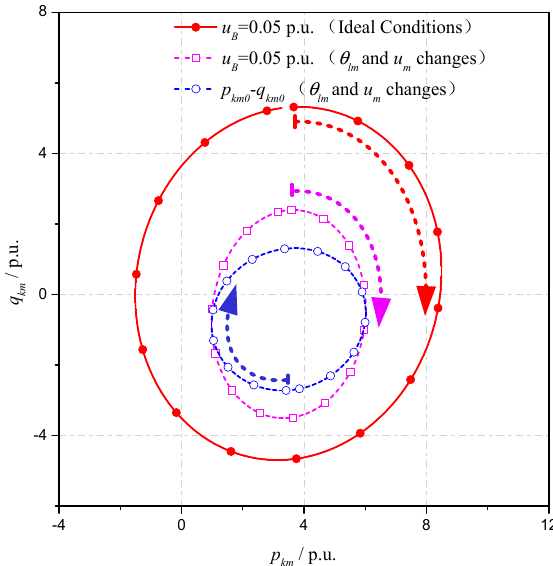
Energies 2020 , 13 , x FOR PEER REVIEW Figure 4. p km - q km curves under different conditions. Figure 4. p km - q km curves under di ff erent conditions.